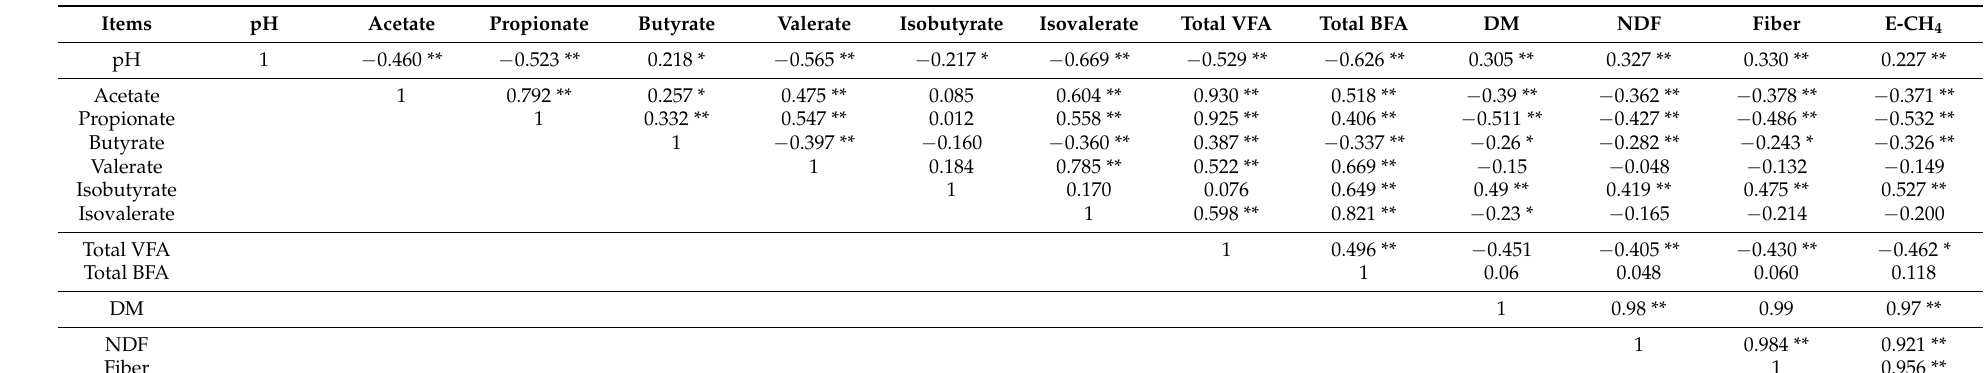
Table 7. Spearman correlation coefficients among VFAs ( µ mol/g), fiber (g · day − 1 ), and E-CH 4 (g CO 2 eq · day − 1 ).